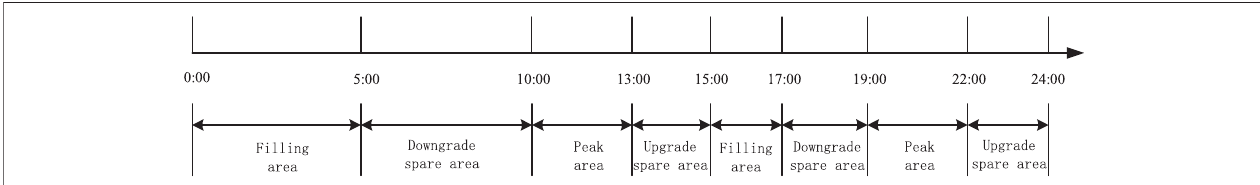
FIGURE 1 | Trading period division of ES ’ s participation in the electricity market.